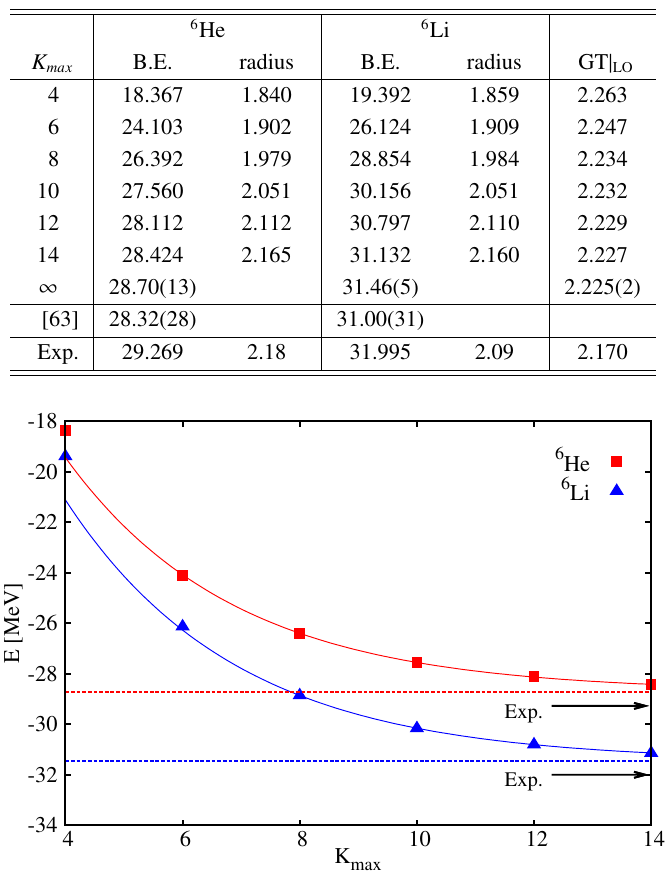
Fig. 6. The convergence of the binding energies of the 6-body nuclei, 6 Li and 6 He. The continuous lines are the fits E ( K max ) = E ∞ + Ae − α K max . The dashed lines are the extrapolated values E ∞ . The experimental values are marked with black arrows. Figure taken from [47].